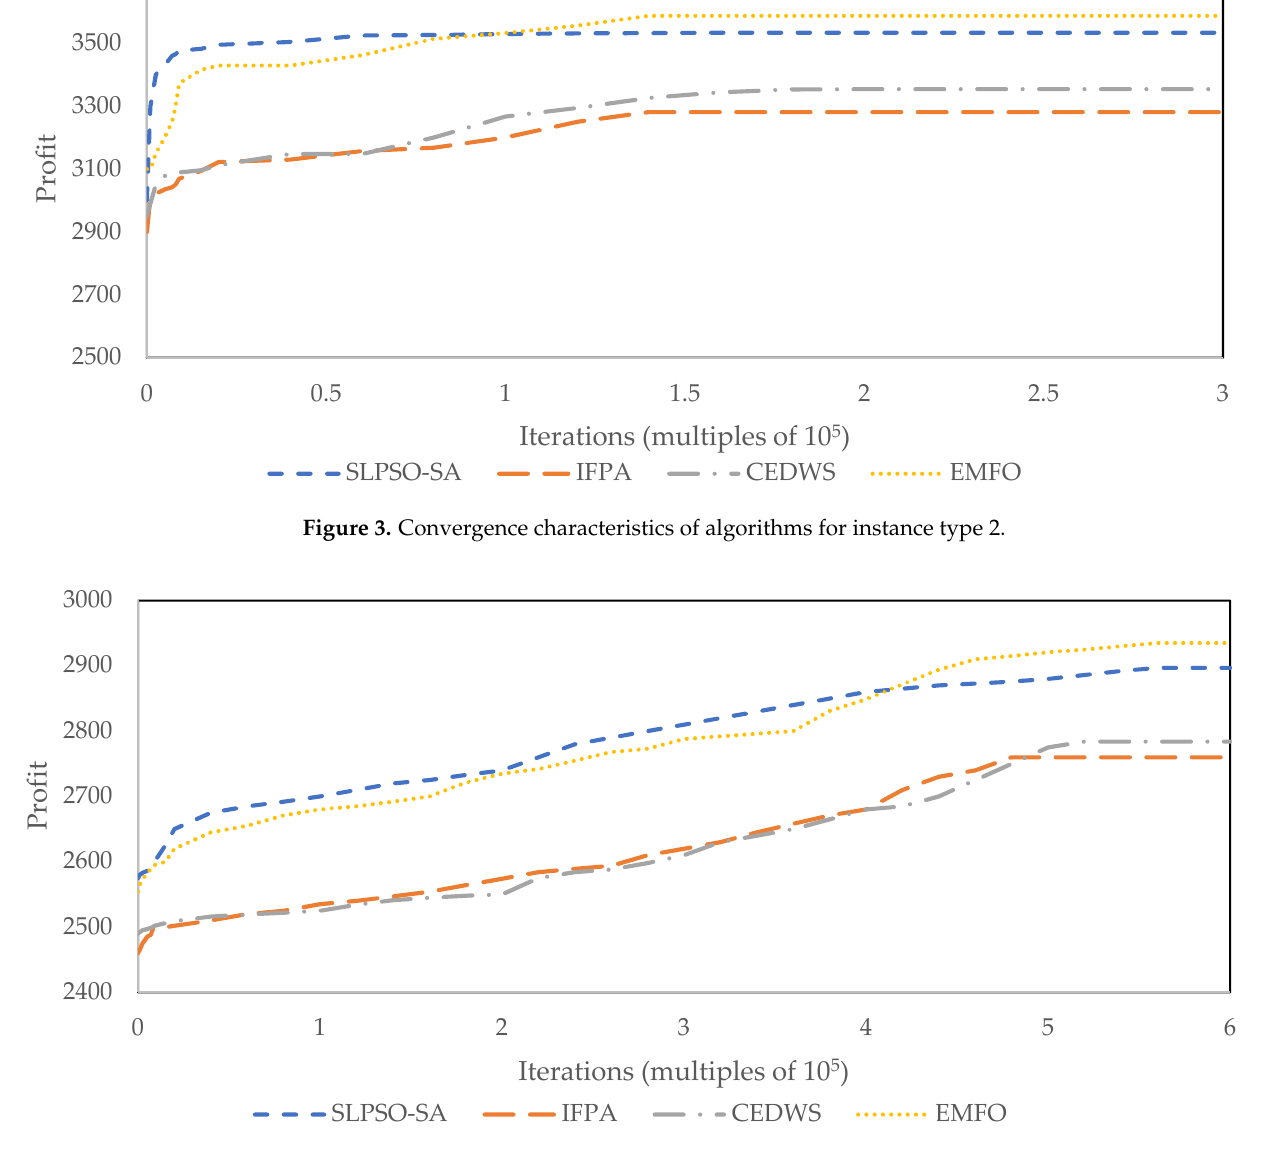
Figure 4. Convergence characteristics of algorithms for instance type 3.